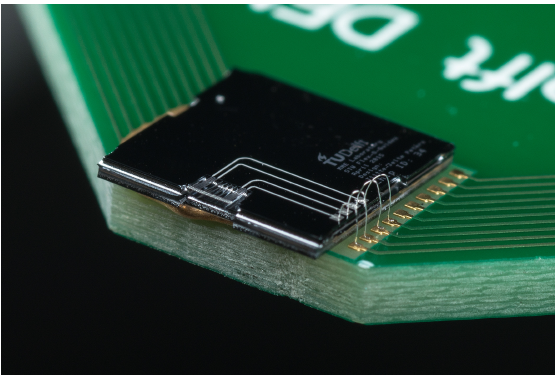
Figure 7. Photograph of a realized PIC with a positionable waveguide array, mounted on a PCB and electrically connected by wire